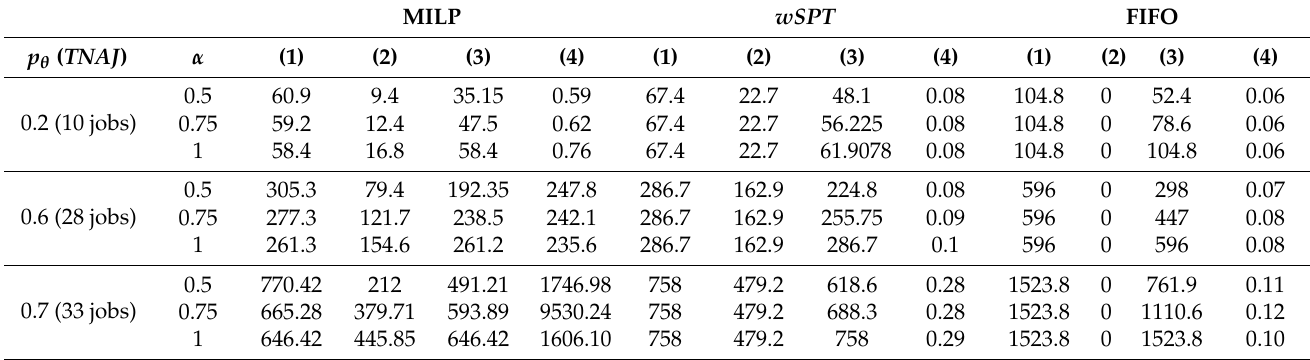
Table 12. Comparison of the results for different solving